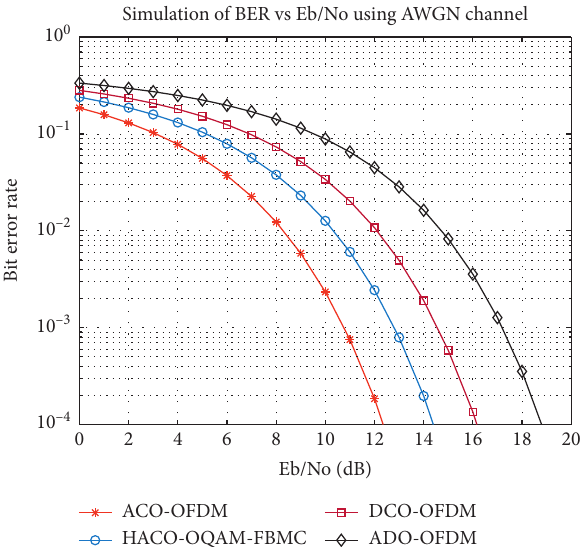
Figure 6: Simulation of BER of ACO-OFDM, DCO-OFDM, ADO- OFDM, and HACO-OQAM-FBMC.